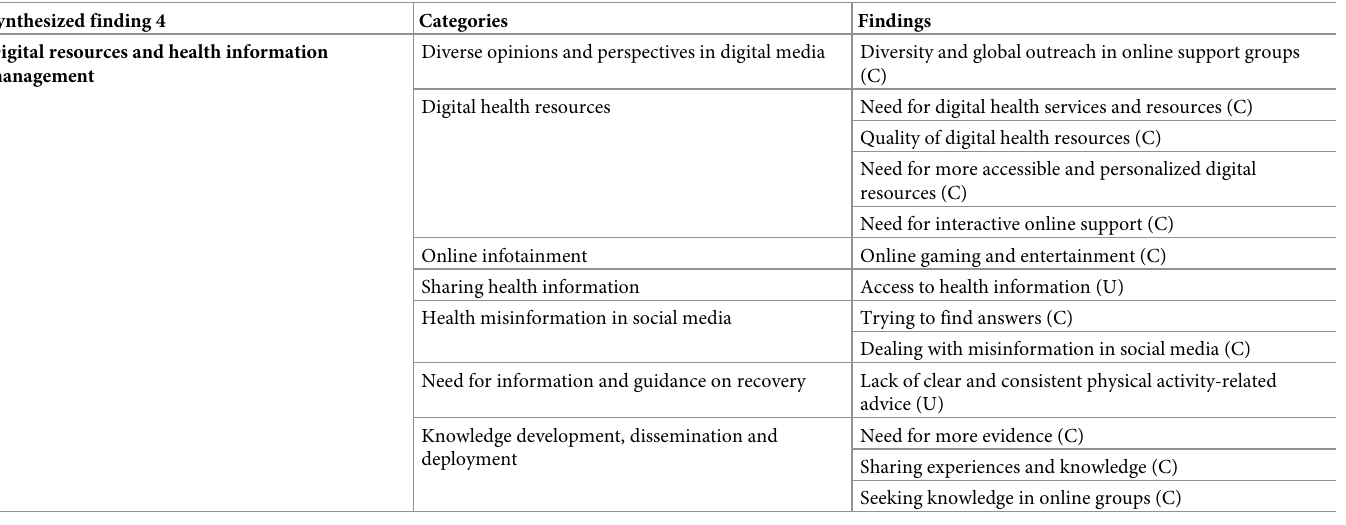
Table 6. Findings and categories within synthesized finding 4. Synthesized finding